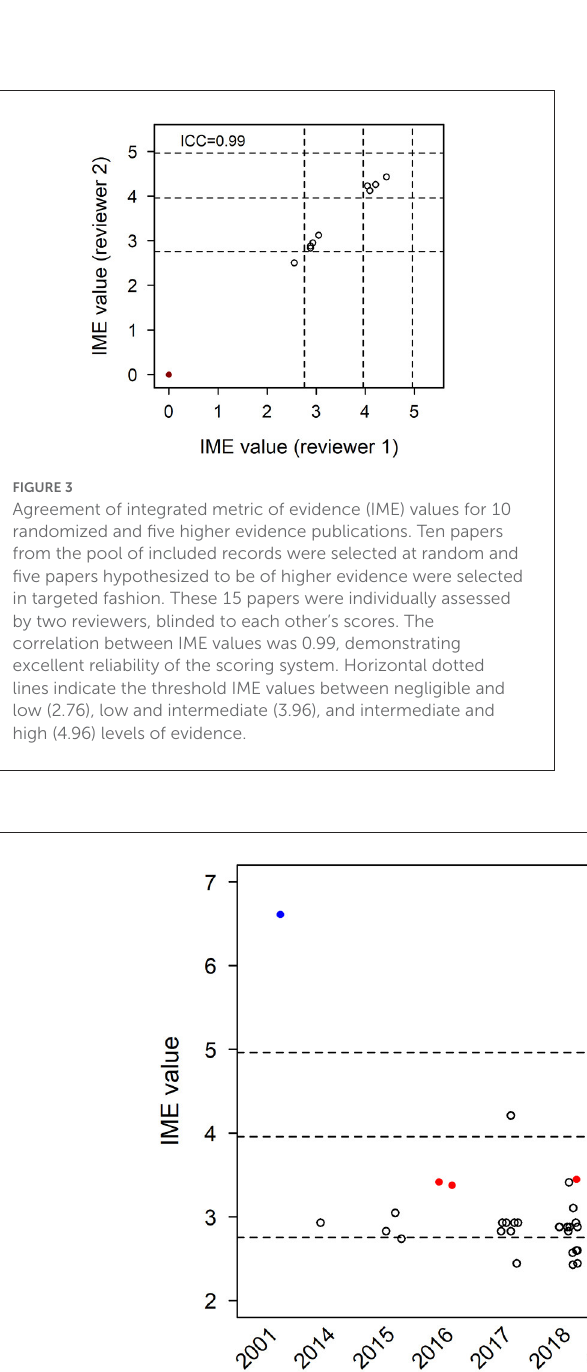
FIGURE4 Integrated metric of evidence (IME) values for immune checkpoint inhibitors. Horizontal dotted lines indicate the threshold IME values between negligible and low (2.76), low and intermediate (3.96), and intermediate and high (4.96) levels of evidence. The median IME value was 2.88 (range 2.05–6.61). The sole prospective, blinded, randomized control trial is represented by a blue circle. Papers excluded from formal analysis but considered in our qualitative review are represented by a red